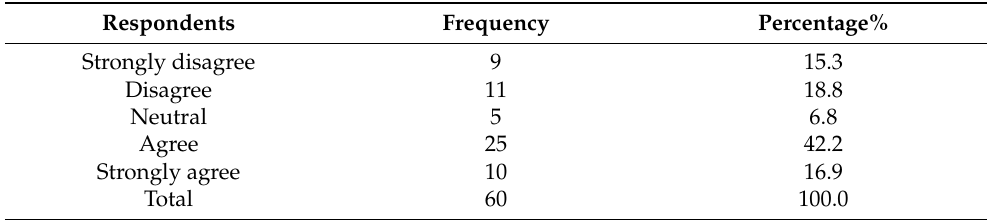
Table 11. The HR department ensures that staff are aware of new technological developments as they emerge in the market.